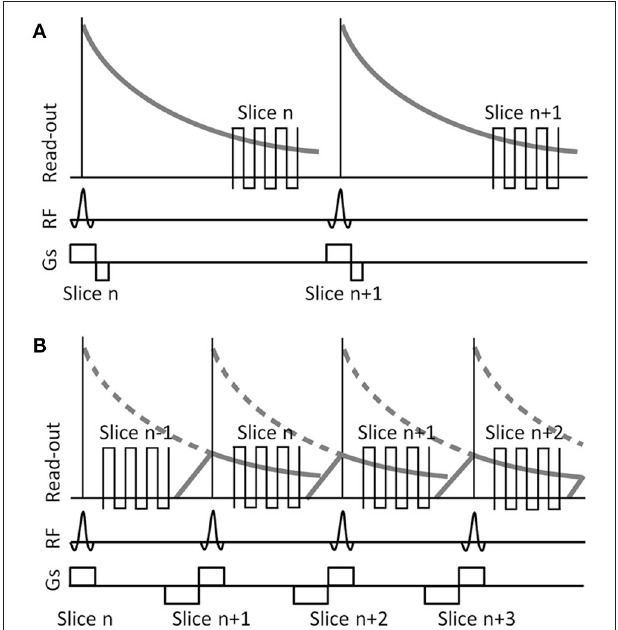
FIGURE 1 | Schematic illustrating slice excitation and read-out for a typical fMRI EPI sequence (A) and a sequence incorporating a shifted-echo (B) . RF, radio frequency. Gs, slice selection gradient. In the typical fMRI EPI sequence data are acquired at a long TE, forcing a long repetition time TR between consecutive RF pulses. In the shifted-echo fMRI EPI sequence, the delay time between the end of the RF excitation and the start of the read-out is used to acquire another slice, effectively reducing the TR to half the time, while maintaining the same long TE for each slice. Gradient spoiling and rephrasing is used to control the signal strength in each